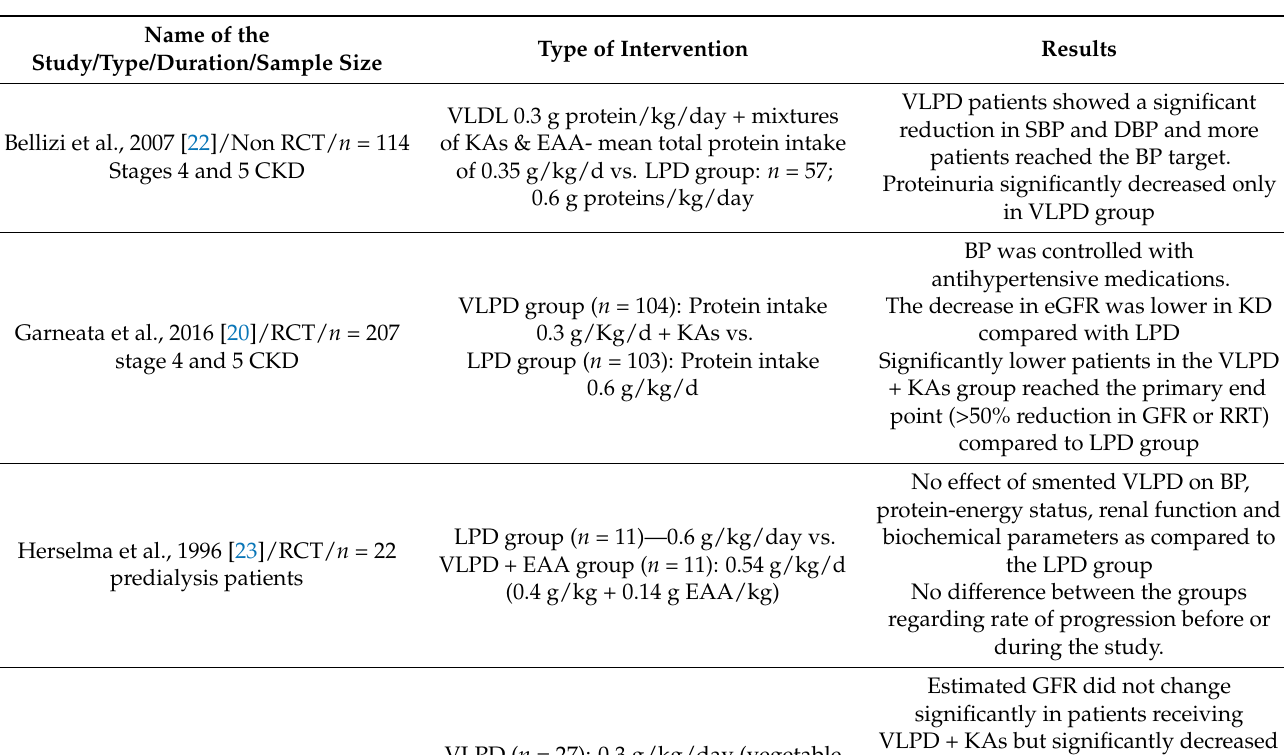
Table 2. Studies of protein restriction +KAs in CKD